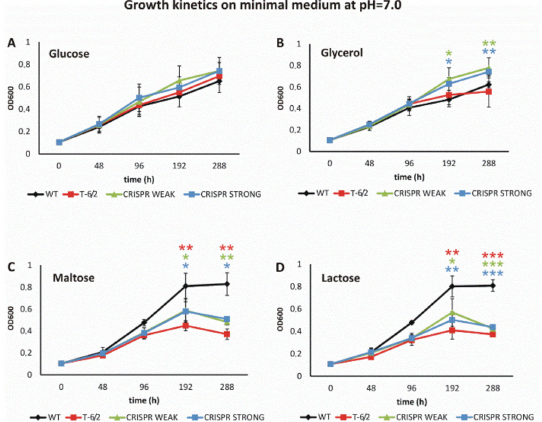
Figure 3. The growth kinetics of Mtb and ppe51 mutants in minimal medium at pH = 7.0 Growth kinetics of the wild-type (black) strain and the T-6 / 2 (red), PPE51 CRISPR weak (green) and PPE51 CRISPR strong (blue) mutants of M. tuberculosis in minimal medium containing glucose ( A ), glycerol ( B ), maltose ( C ) or lactose ( D ), at pH = 7.0. The kinetics were evaluated by measuring the absorbance at 600nm at the indicated time points. The displayed values are the means ± standard errors of at least three independent experiments. Statistical significance: one, two and three stars denote p -values ≤ 0.05, ≤ 0.01 and ≤ 0.001, respectively (Student’s t -test). Statistical significance of growth between the wild-type strain and the T-6 / 2 (red star), PPE51 CRISPR weak (green star) and PPE51 CRISPR strong (blue star) mutants was analyzed at 192 and 288